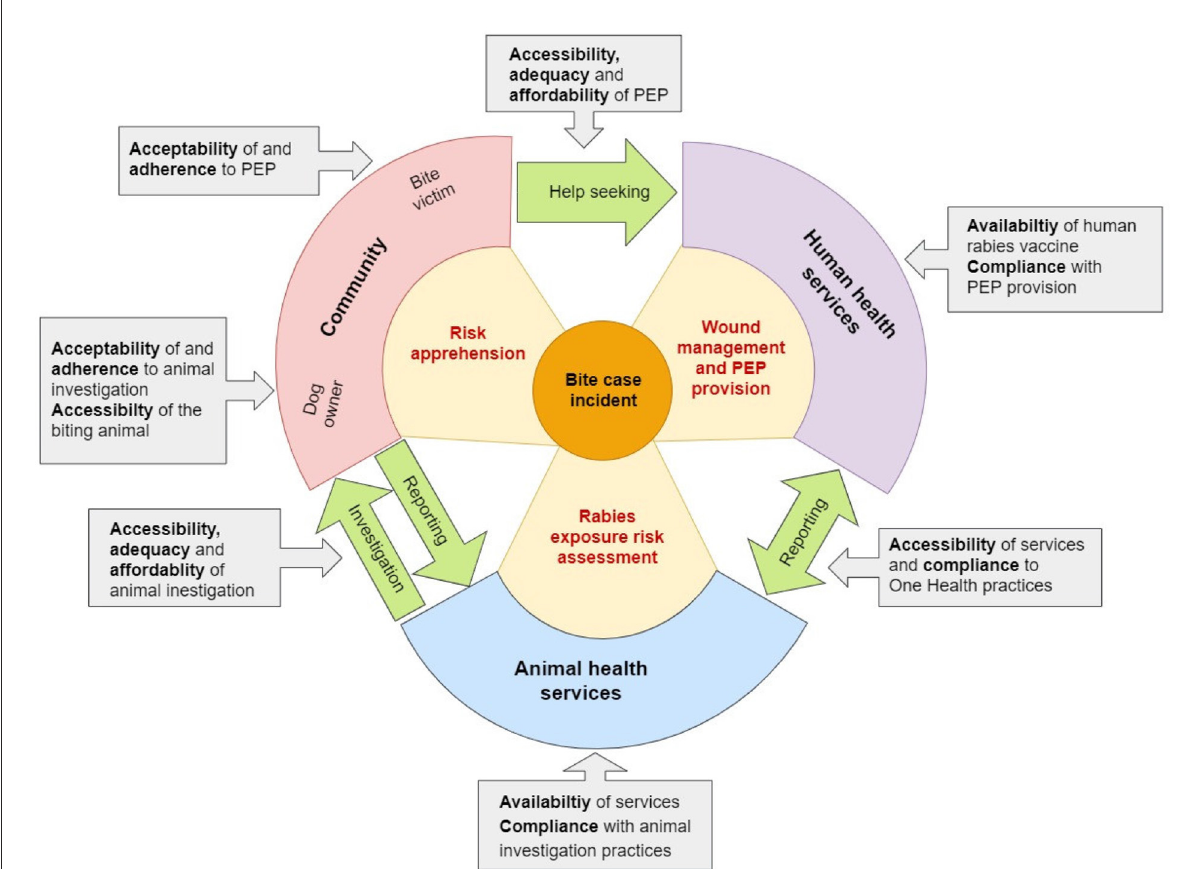
FIGURE1 The integrated bite case management (IBCM) access cycle with the various access elements described by Obrist et al. (15) (gray boxes) influencing on different levels of the cycle (community, human health and animal health services). Red text in the cones describes the roles of the primary actors involved in IBCM. Green arrows highlight the communication actions that need to be undertaken between the three